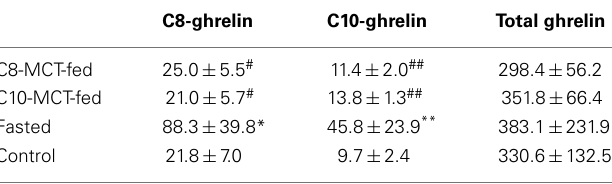
Table 4 | Plasma ghrelin levels under different nutritional